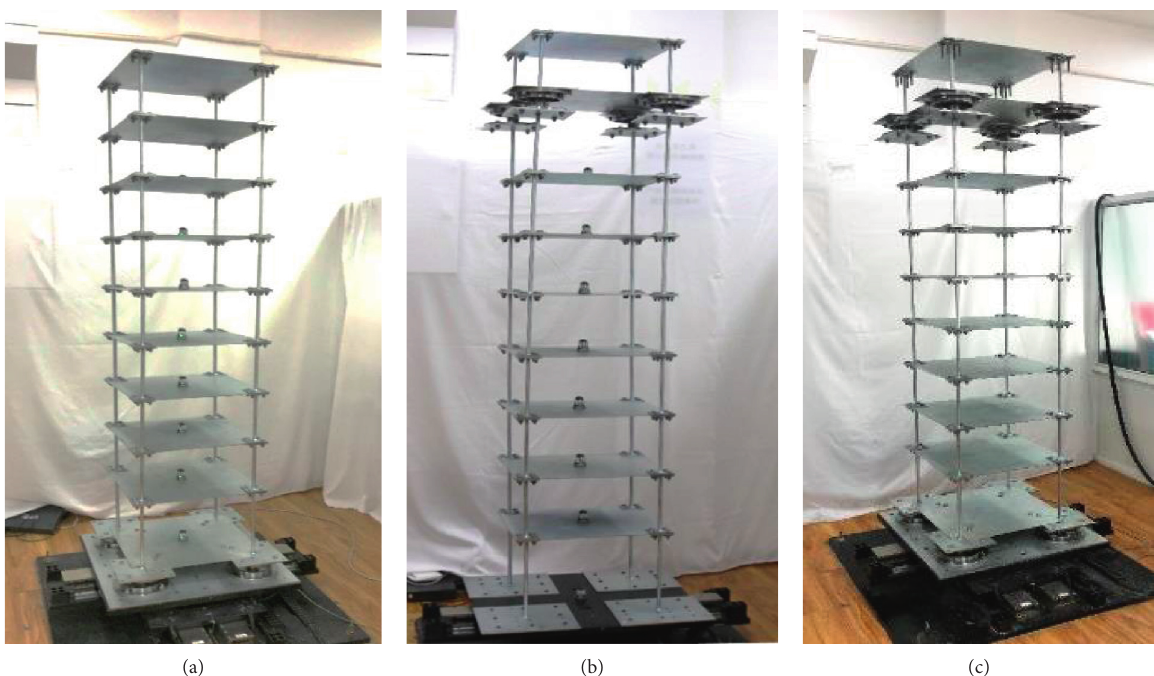
Figure 16: Test model. (a) FPS base isolation structure. (b) FPS inter-storey isolation structure. (c) FPS dual isolation